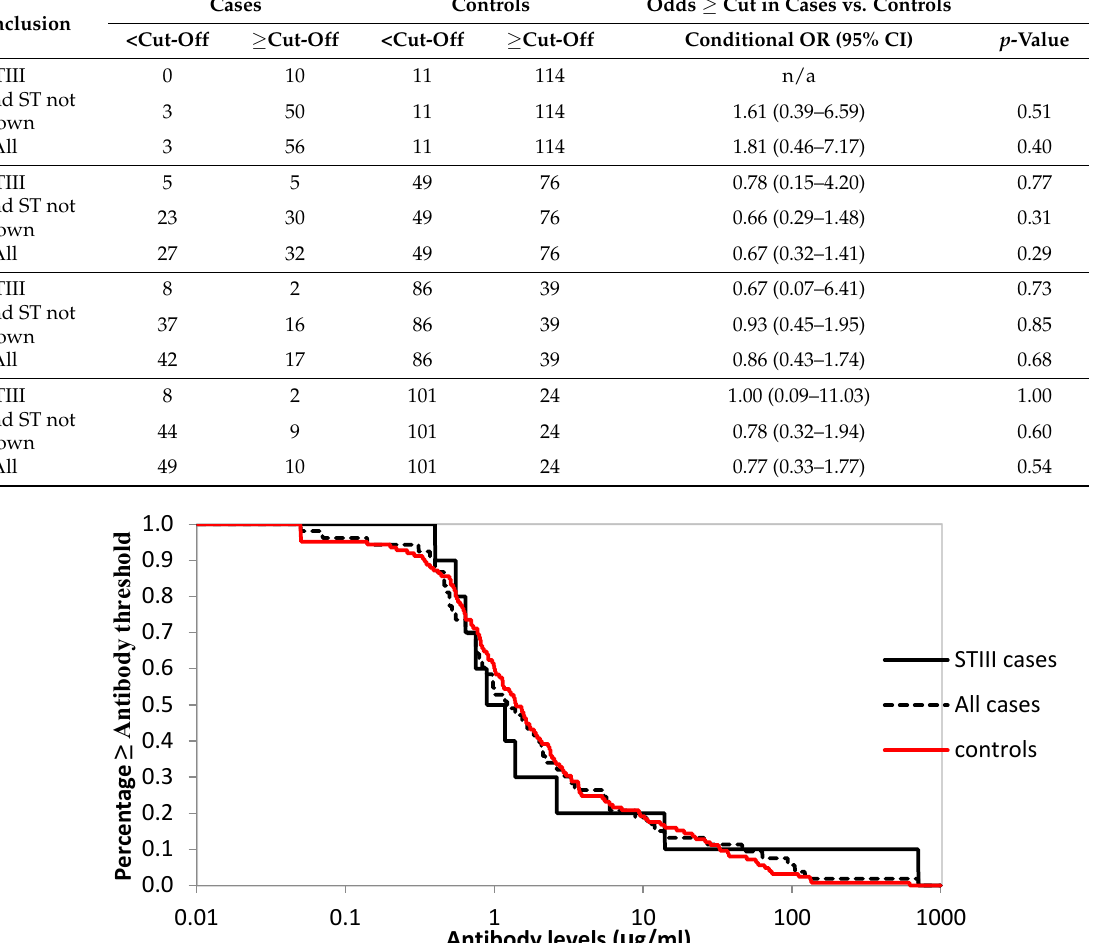
Figure 2. IgG antibody concentrations for serotype III LOD cases vs. controls. Median and inter- quartile ranges of IgG levels shown. On the left, controls ( n = 11); on the right, cases ( n = 6).